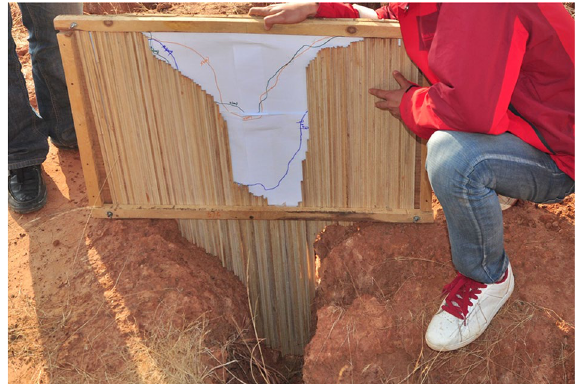
Figure 7. The microtopographic profiler.